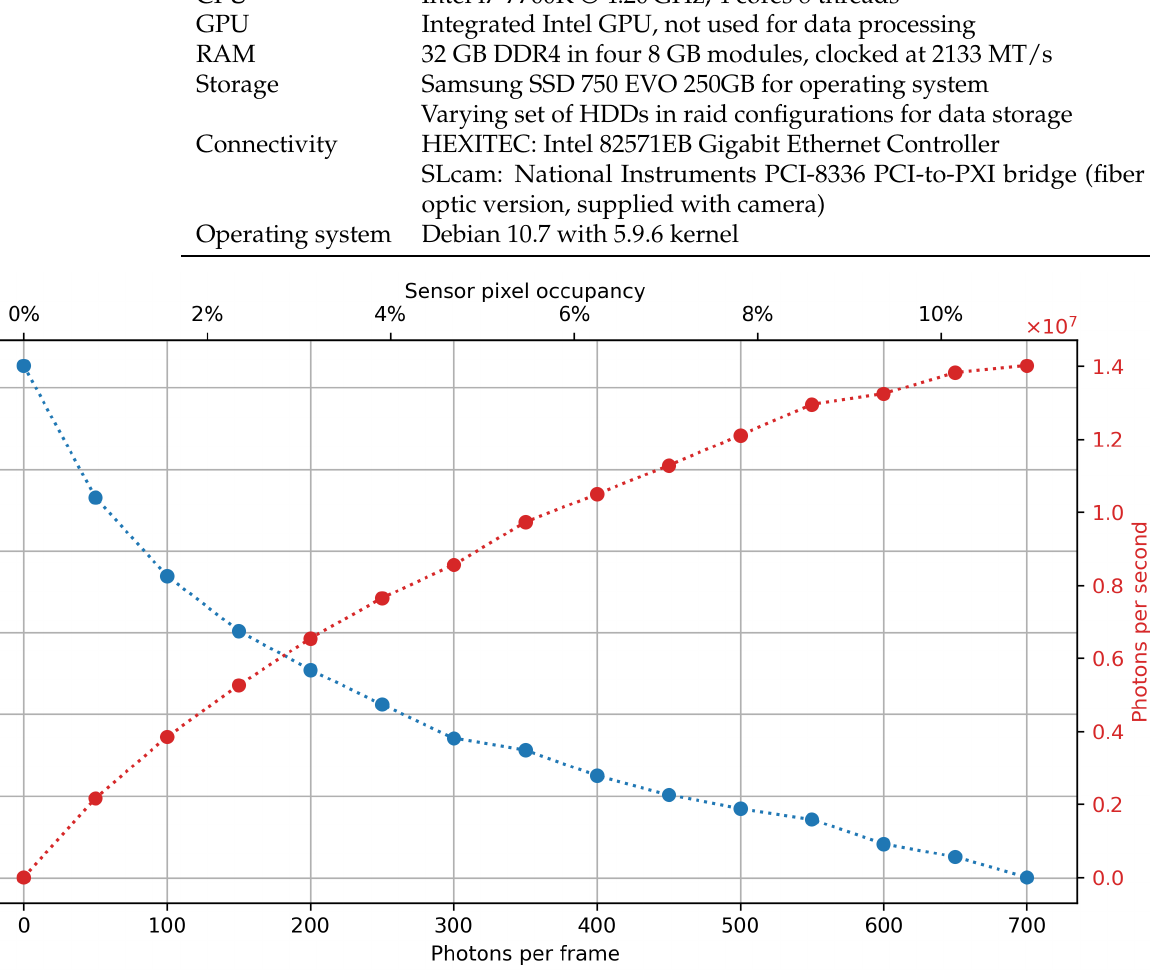
Figure 7. Maximum throughput in frames per second for HEXITEC-type frames at varying photon counts per frame. This benchmark shows the single-core performance of the SpeXIDAQ implementation, and can scale roughly by the amount of CPU cores. The flood-fill algorithm is moderately sensitive to the total count of reconstructed events per frame, with the decrease in throughput flattening out as pile-up becomes the dominant source of reconstructed